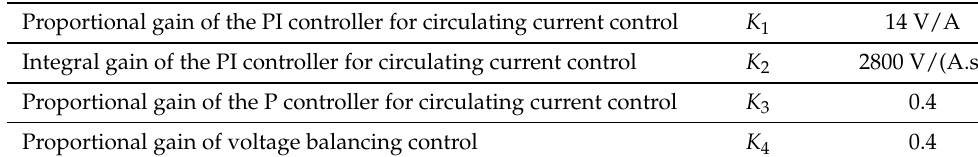
Table 4. Control gain parameters used for the simulation.